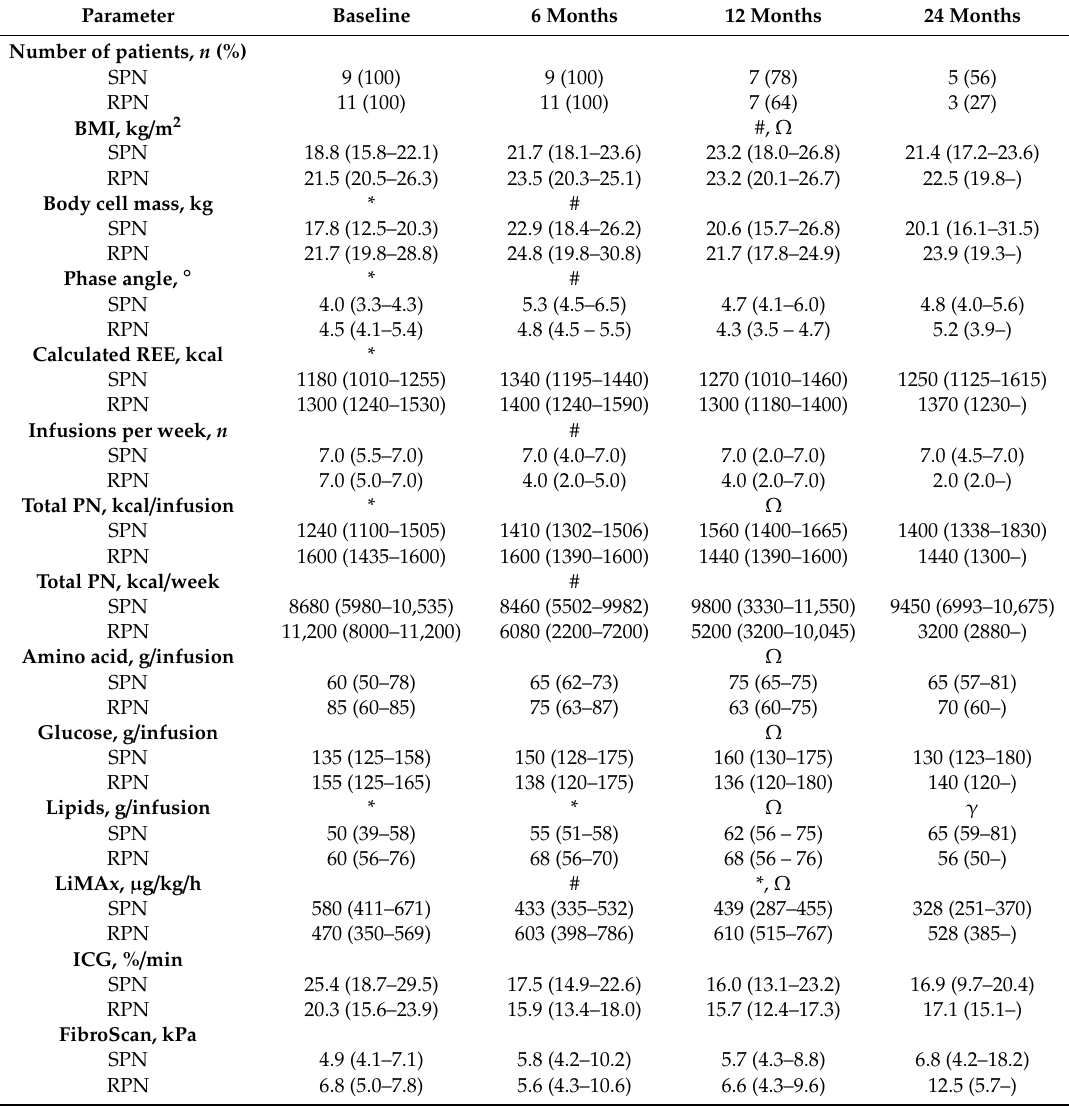
Table 2. Longitudinal